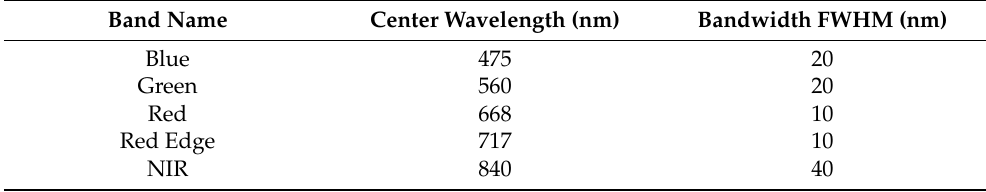
Table 1. Specification of wavelength and bandwidth of multispectral camera